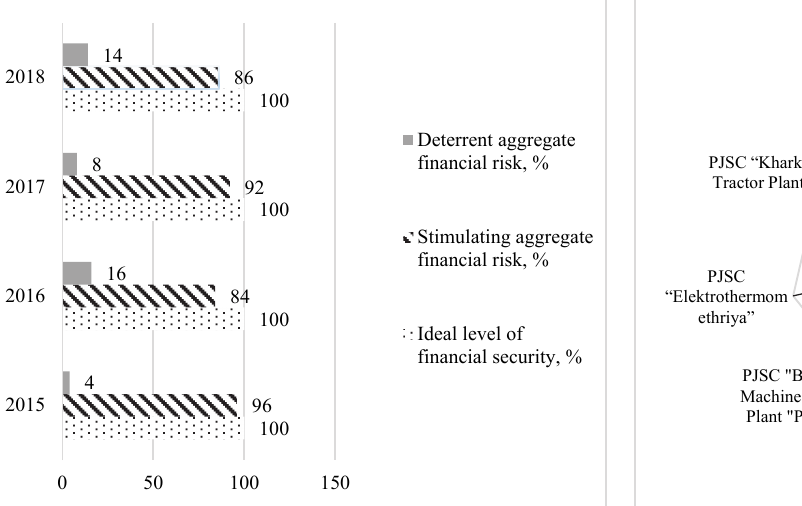
Fig. 4. Integral financial risk containment of joint-stock machine- building companies of Ukraine for the period 2015-2018* *Source: compiled by the